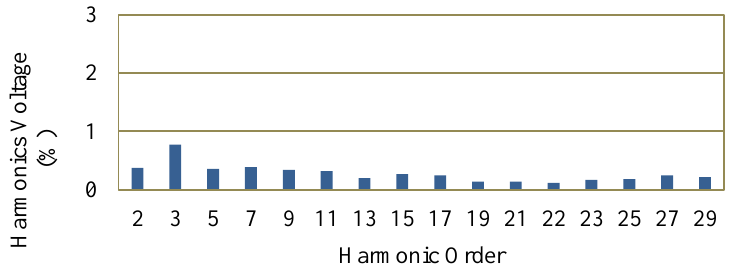
Figure23. Voltage harmonic distribution at 25% load.